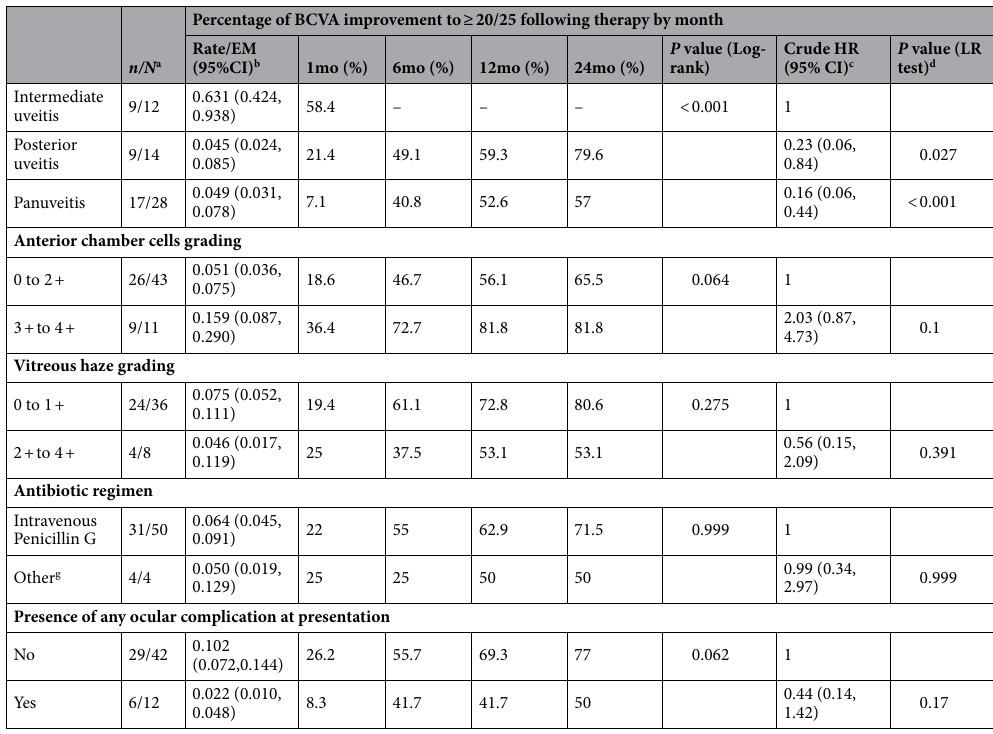
Table 4. Incidence of and predictive factors for BCVA improvement to ≥ 20/25 in eyes of patients with syphilitic uveitis following antibiotic therapy. ART : Antiretroviral therapy; BCVA : Best corrected visual acuity; CI : Confidence interval; CSF : Cerebrospinal fluid; EM : Eye-months; HIV : Human immunodeficiency virus; MSM : Men who have sex with men; mo: month. a n/N indicates number of events/number of eyes at risk. b Incidence rate is number of events divided by the total eye-months at risk. c Crude HR = hazard ratio for univariate Cox proportional model. d Likelihood ratio test. e The events BCVA of ≥ 20/25 were achieved at 36 months after therapy. f Calculated in eyes of HIV- infected patients only. g Others included ceftriaxone and